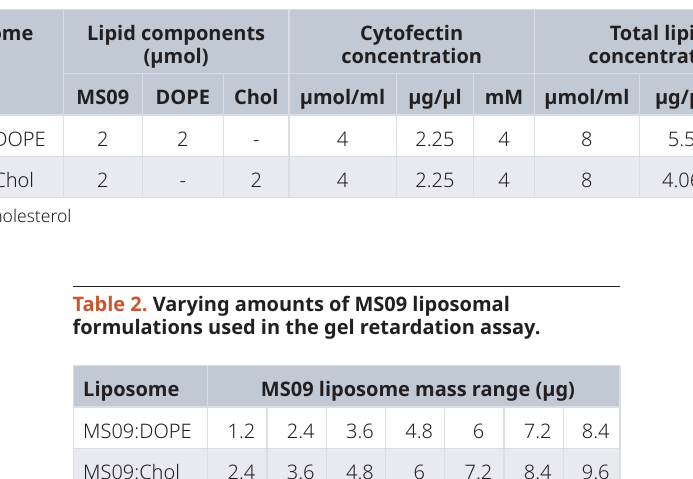
Table 1. Composition of prepared cationic liposomes.